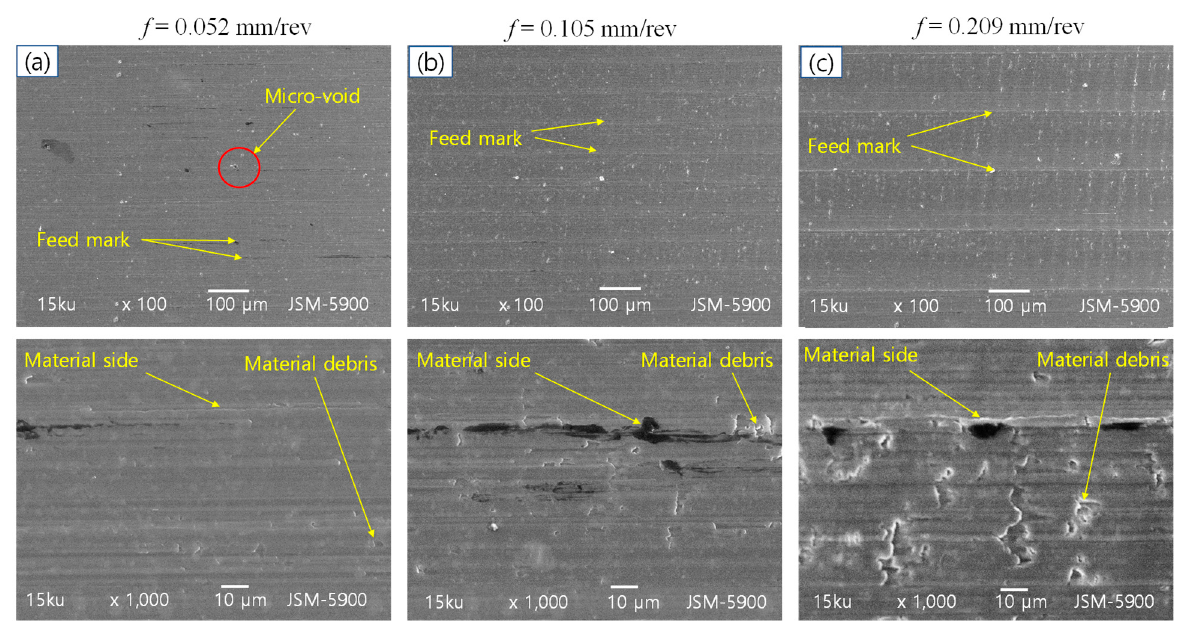
Figure 6. Micro-image of machined surface for spindle speeds of ( a ) 510, ( b ) 710 and ( c ) 1010 rpm at 100× and 1000× magnifications (SEM) with a combination of cutting parameters r 1 and 0.052 mm/rev.